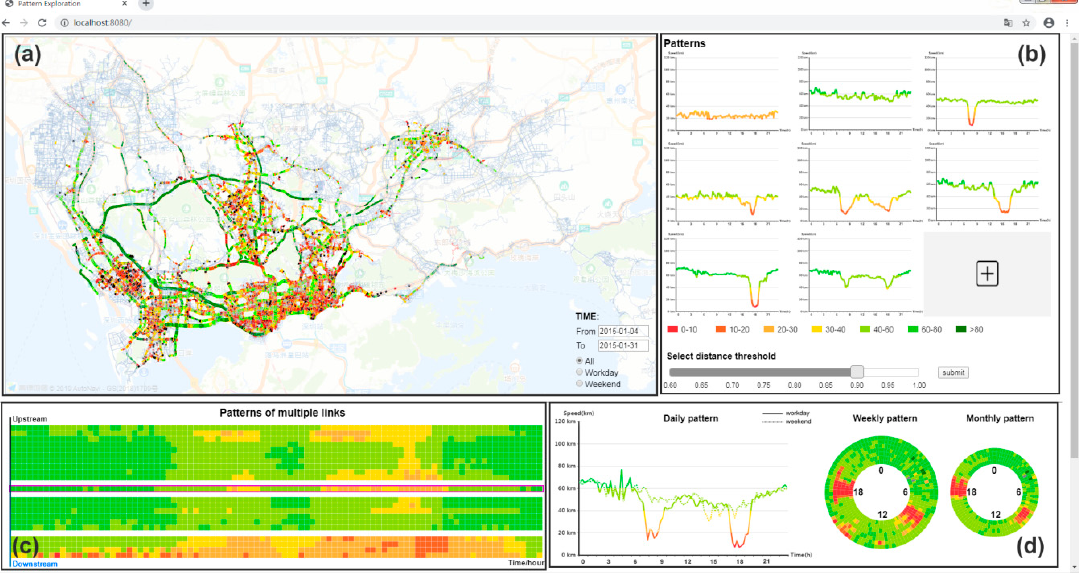
Table 2. Descriptive statistics of road segments with repeated traffic states.